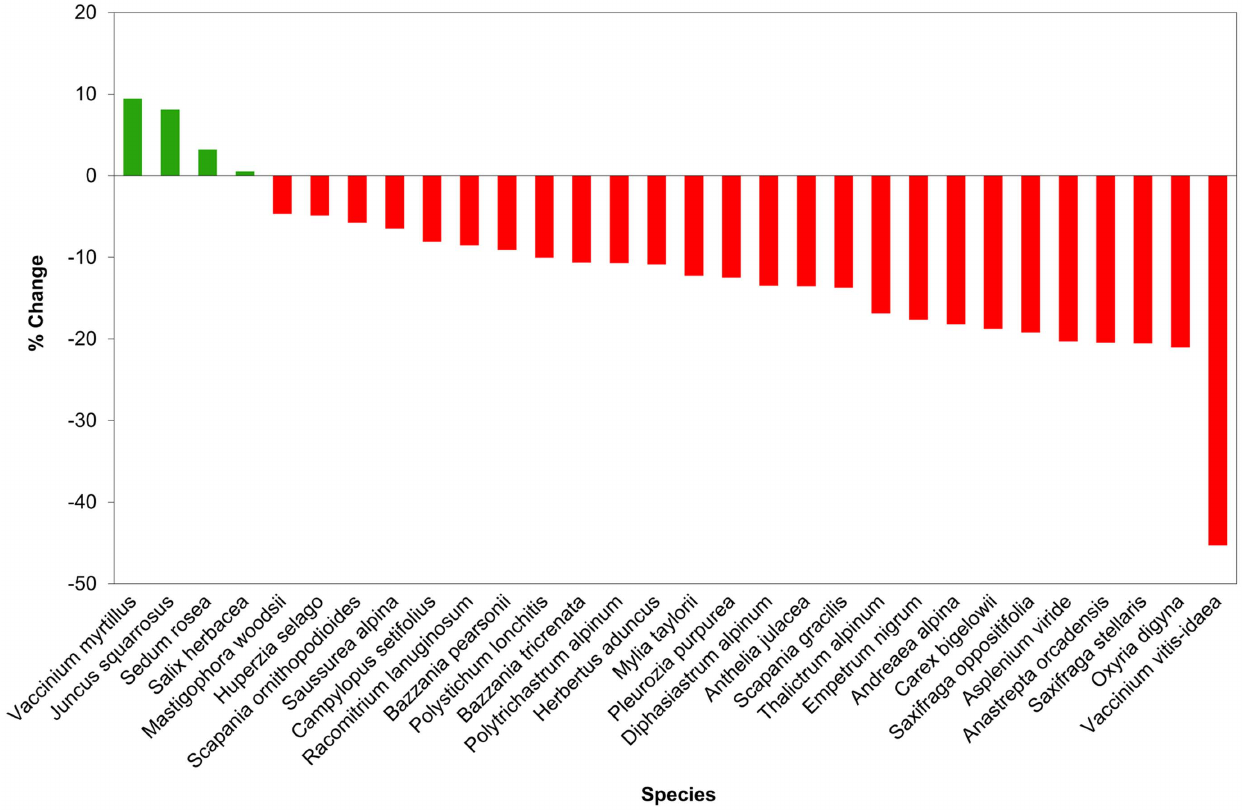
Figure 5. Projected percentage change in overlap with protected areas from current to future distribution, for all species modelled.